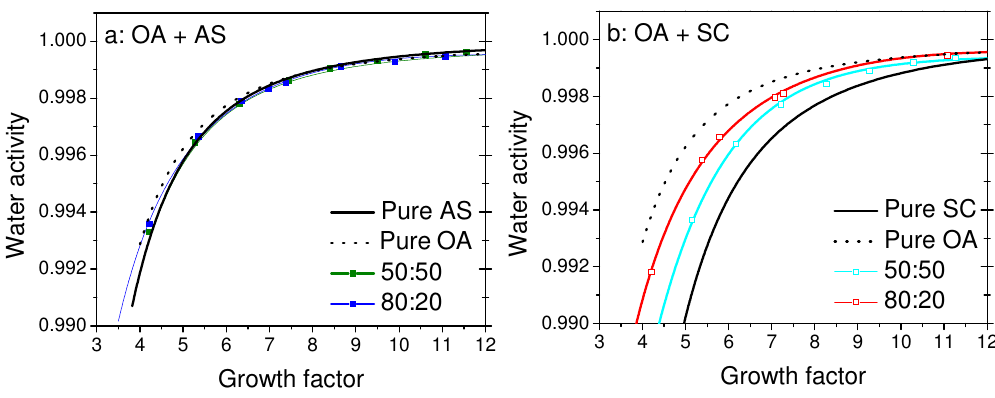
Fig. 4. (a) Measured water activity and fitted functions for the two mixtures containing oxalic acid dihydrate (OA) and ammonium sulphate (AS). (b) Measured water activity and fitted functions for the two mixtures containing oxalic acid dihydrate and sodium chloride (SC). The data is compared to water activities of ammonium sulphate or sodium chloride (Low, 1969; Young and Warren, 1992) and oxalic acid (based on Varga et al.,